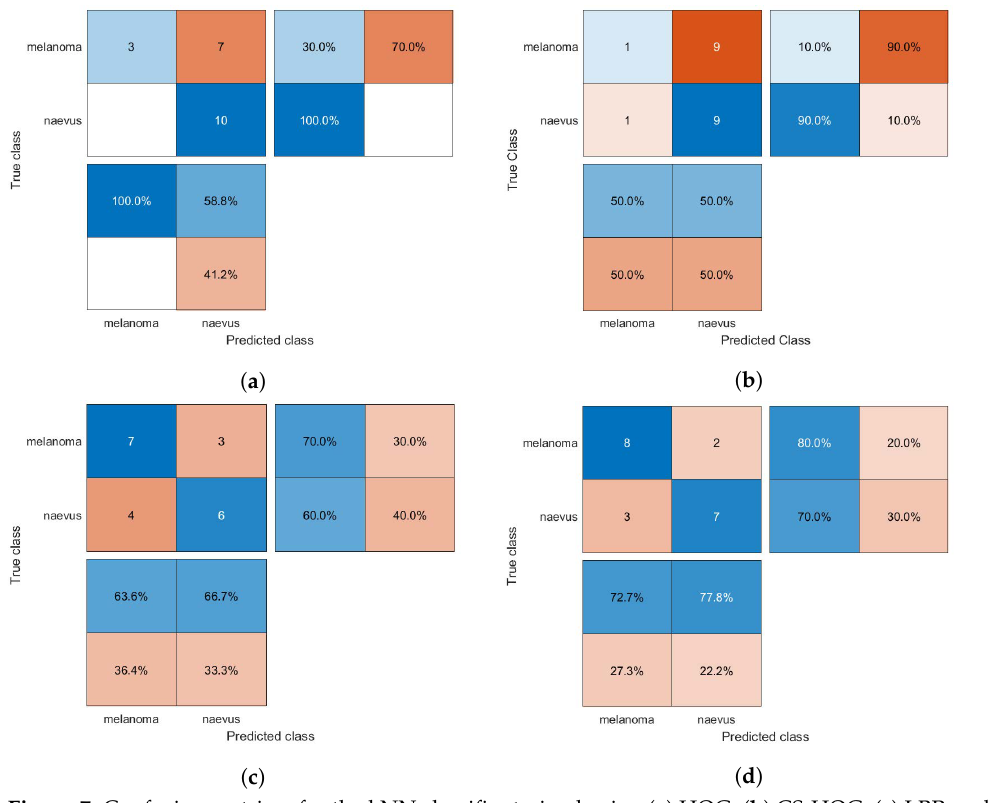
Figure 7. Confusion matrices for the kNN classifier trained using ( a ) HOG, ( b ) CS-HOG, ( c ) LBP, and ( d ) N-LBP features.